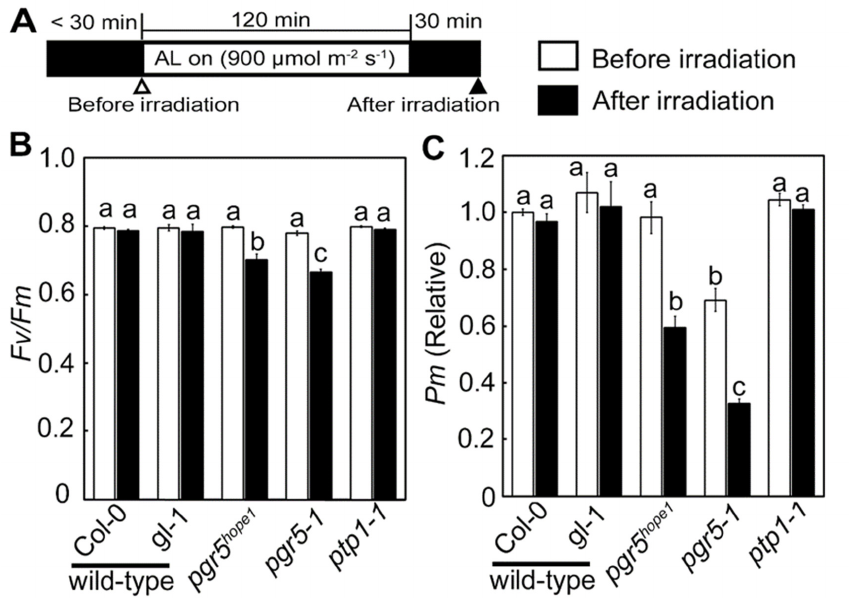
Figure 6. The extent of photoinhibition by constant intense light. ( A ) is an illustration of an experimental scheme for photoinhibition by constant intense light. The leaves that had been fully darkened (<30 min) were exposed to intense constant light (AL; 900 μ mol-photons m − 2 s − 1 ) for 2 h under atmospheric conditions, and then darkened for 30 min. Saturated pulse flush was exposed before AL on (before irradiation) and after darkness for 30 min with AL off (after irradiation). ( B , C ) show the maximum quantum yield in PSII ( Fv / Fm ) and the maximum amount of photo-oxidizable PSI ( Pm ) before and after irradiation, respectively. Black and white bars are before and after irradiation. In C , Pm is a relative value with the value wild-type Col-0 before irradiation being 1. Data are means ± sd. ( n = 3) Experiments were independently repeated at least 3 times with similar results. Graphs show representative results. 4. Discussion In this study, we identified the AT2G17240 gene, named PTP1 , as a novel factor for PSI photoprotection. Mutations in PTP1 exacerbated PSI photoinhibition and reduced the growth of pgr5 and pgrl1 mutants. PGR5 and PGRL1 that form a protein complex are sug- gested to be the main components of cyclic electron transport around PSI (CEF-PSI) [21,22], but its actual molecular function has not yet been specified. ptp1-1 deficient mutant performed the same photosynthetic activity including Δ pH formation (NPQ) as wild-type plants (Figure 5). In addition, PTP1 was reported as CGL20A to function in ribosome bio- genesis in plastids [34]. Thus, PTP1 was unlikely to be directly involved in the linear elec- tron transport or CEF-PSI. The physiological roles of CEF-PSI were suggested to protect PSI from excess light energy by sustaining high Δ pH and produce ATP for CO 2 assimila- tion [28]. However, pgr5 hope1 showed significantly larger Pm than pgr5-1 under both con- stant and natural light conditions (Figure 2C,F) and showed nearly the same CO 2 assimi- lation level as wild-type under saturated light conditions (Figure 5A). These results indi- cated that the physiological roles of CEF-PSI based on the analysis of pgr5-1 could have been overestimated. In addition, it was suggested that the existence of CEF-PSI itself needed to be recon- sidered in other experiments. As for the CEF-PSI pathway carried by PGR5 and PGRL1, ferredoxin-quinone reductase dependent (FQR) pathway in which electrons transfer from ferredoxin (Fd) to plastoquinone (PQ) in the electron transport chain is proposed. How-